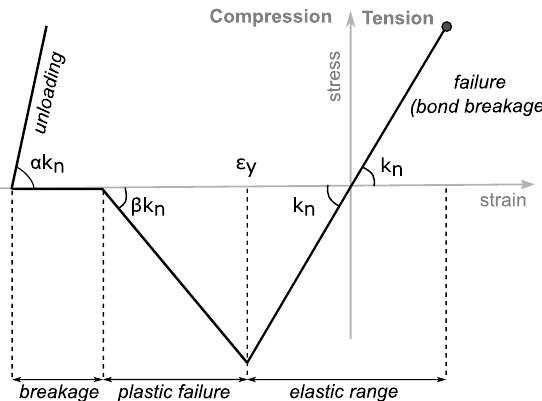
Figure 10. Schematic stress-strain diagram for solid bond loaded in normal